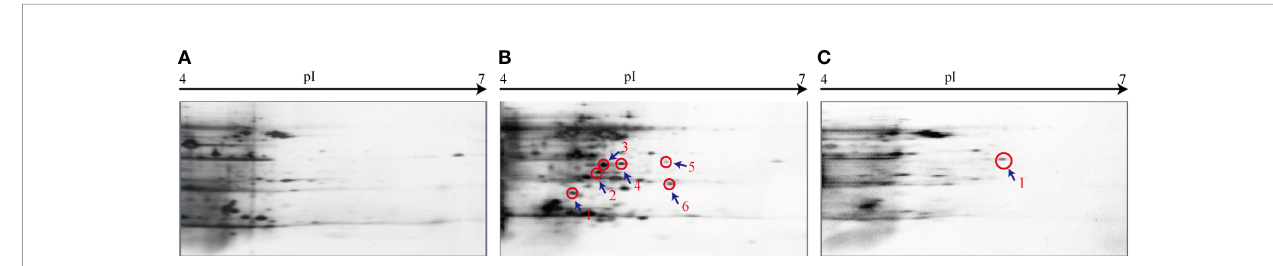
FIGURE 6 | The 2-DE analysis of extracellular proteins of V. parahaemolyticus CHN25, D VpaChn25_0724 , and D VpaChn25_0724 -com strains. (A) Wild type; (B) D VpaChn25_0724 ; (C) D VpaChn25_0724 -com.